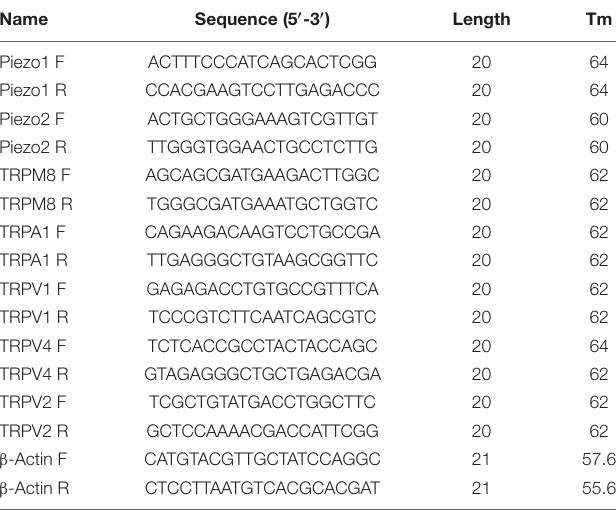
TABLE 1 | Oligonucleotide primer sets for quantitative real-time PCR